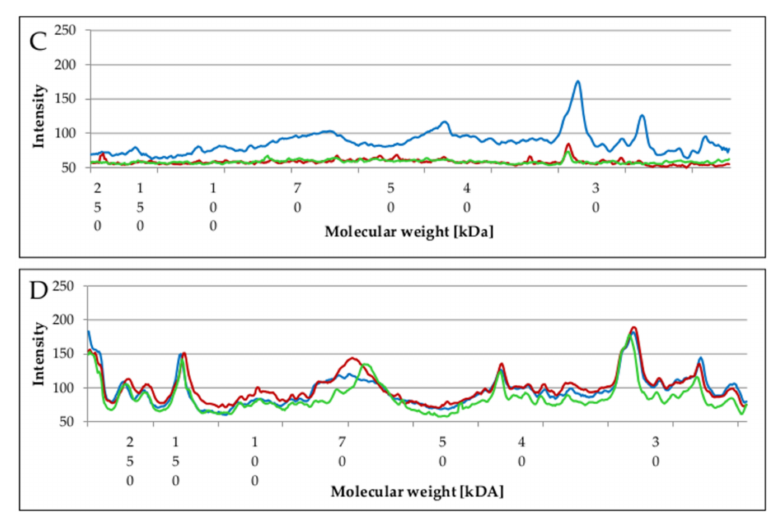
Figure 4. Changes in pixel intensities of protein profiles in P. aeruginosa PB_1 planktonic cells ( A , B ) and biofilm ( C , D ) after gemini surfactant C6 ( A , C ) and monomeric surfactant DTAB ( B , D ) treatment at 1 ⁄ 4 MIC concentration (red line), 1 ⁄ 2 MIC concentration (green line) in comparison to the sample without biocide (blue